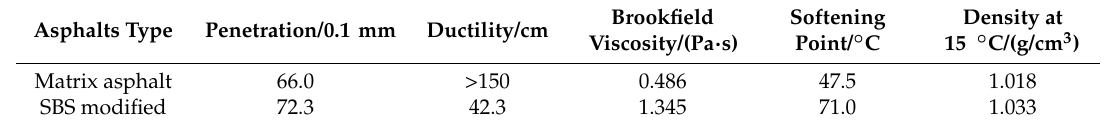
Table 1. Technique performance of